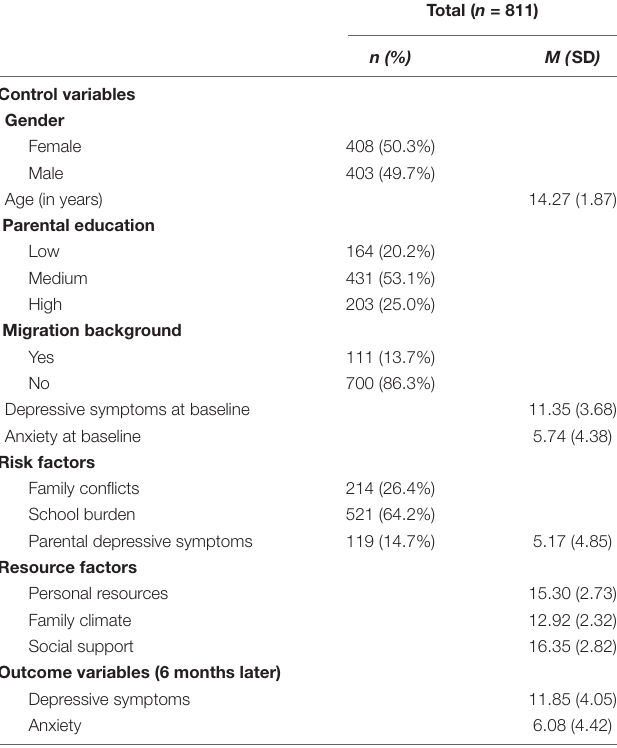
TABLE 1 | Description of the analyzed sample of children and